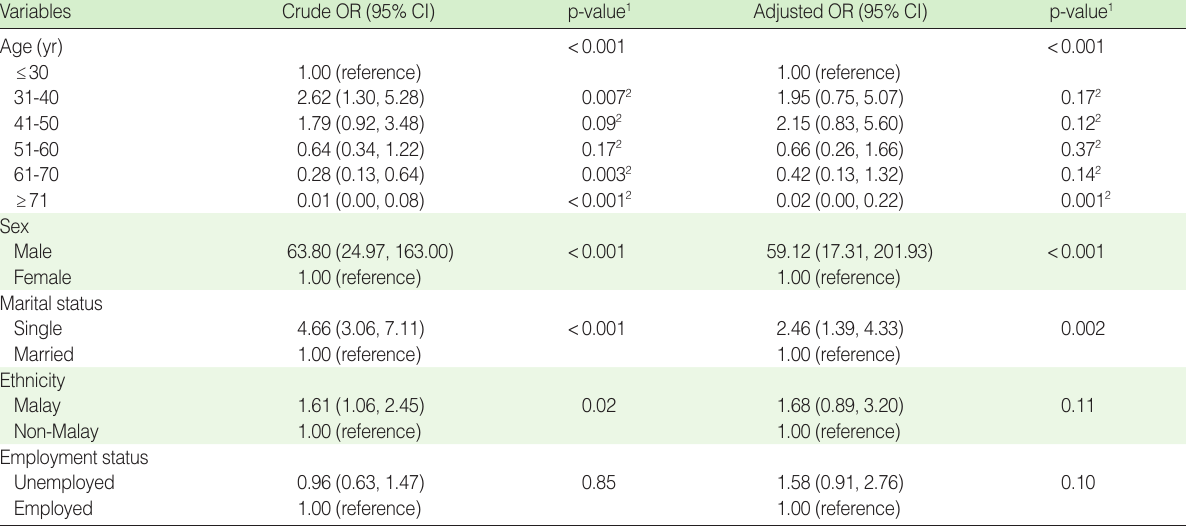
Table 4. Association between demographic characteristics and intravenous drug use as a risk factor for hepatitis C